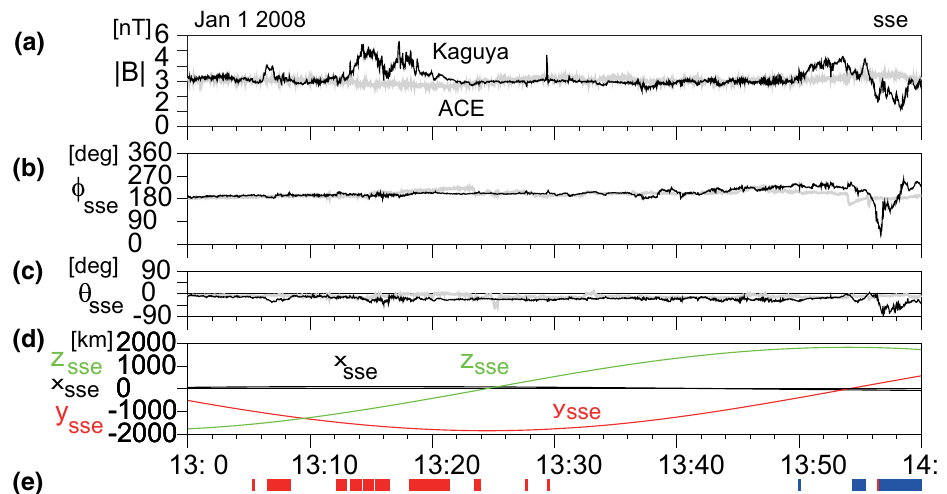
Fig.1 A short-period magnetic enhancement detected by Kaguya at 100 km above the moon. a The magnitude, b the azimuthal angle, and c the latitude angle of the magnetic field observed by Kaguya (black curves) in the Selenocentric Solar Ecliptic (SSE) coordinate system compared with that of the upstream solar wind observed by ACE (gray curve) in the Geocentric Solar Ecliptic (GSE) system shifted by a travel time of 1.06 h from ACE to Kaguya. d The position of Kaguya in SSE coordinates. e The magnetic connection between Kaguya and the dayside (red) or nightside (blue) lunar surface estimated from linear extrapolation of the magnetic